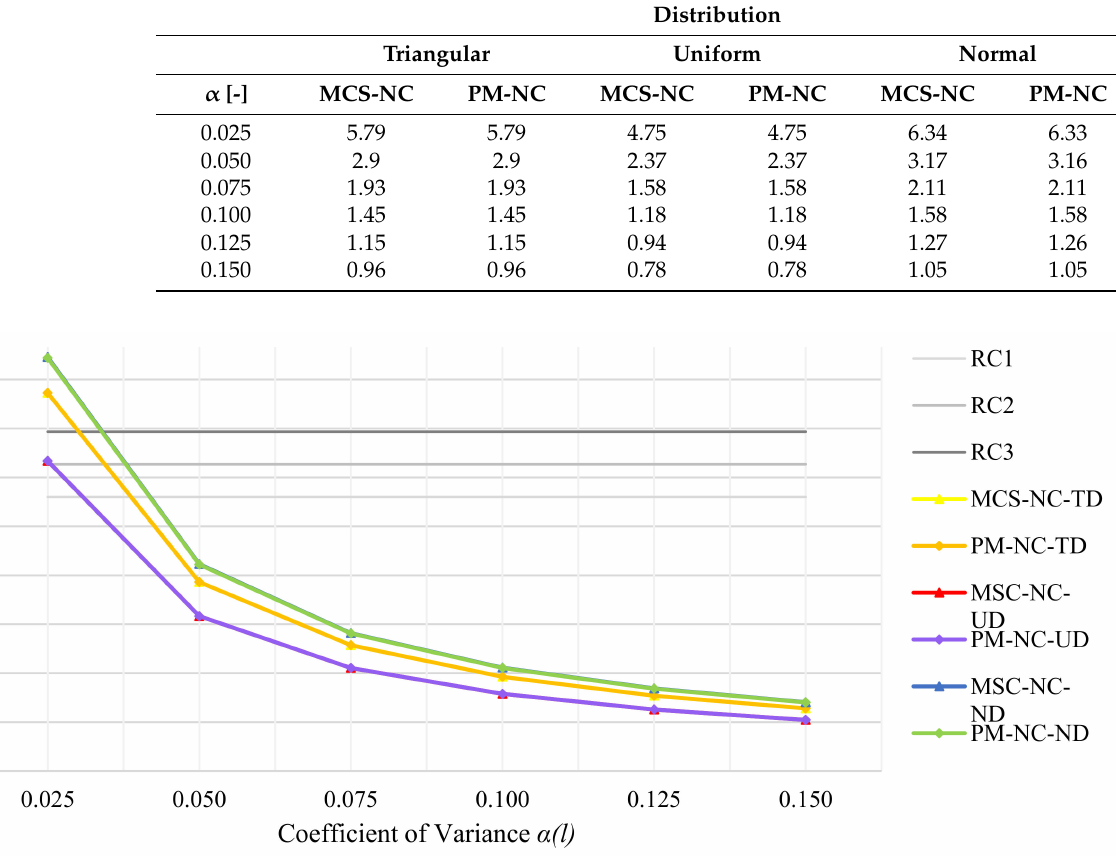
Figure 17. Reliability index β in the